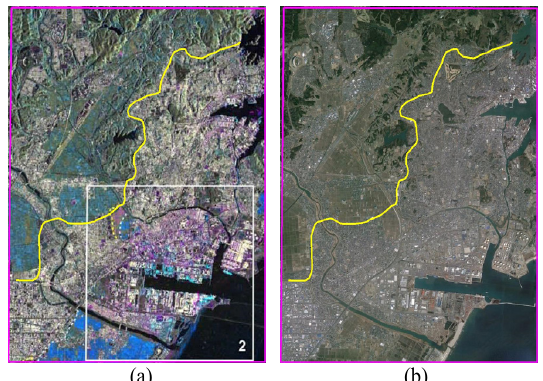
Figure 5. (a) The cut-out of the thematic map in the computation area in the study case of complex area. The meanings of the symbolic colors are described in the caption of Figure 3. The frame of this area can be seen within the pink square in Figure 1. The yellow line specifies the boundary between the flood-free (top-left part) and flood-influenced (down-right part) areas by the tsunami. (b) The counterpart of (a) with the Google Earth image overlaid for overview of ground situation.